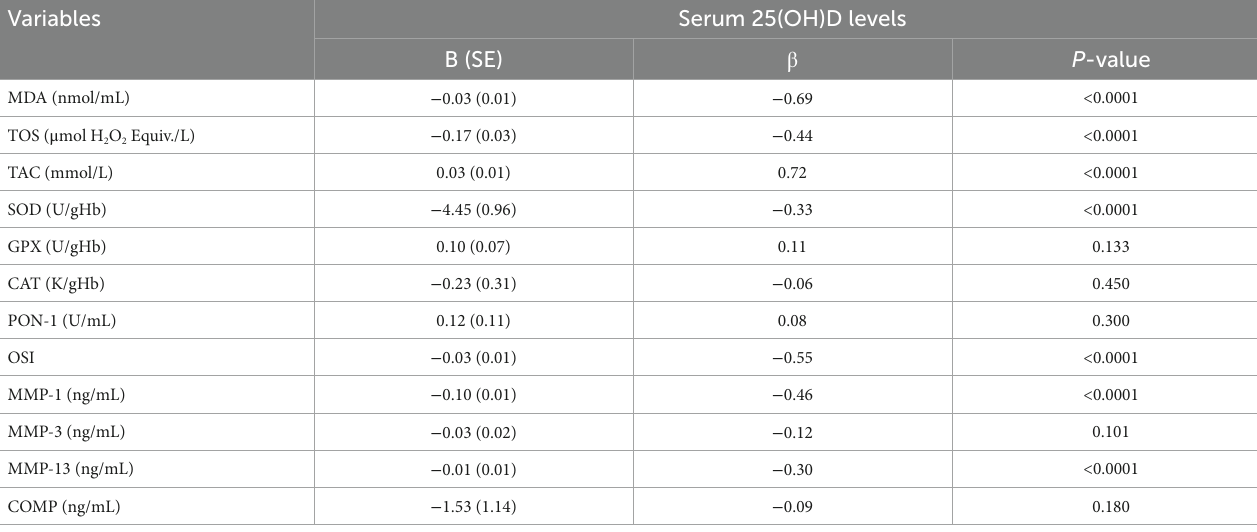
TABLE 3 Results of multiple linear regression analysis that evaluated the association between serum 25(OH)D with oxidative stress markers and matrix metalloproteinases ( n = 189). a